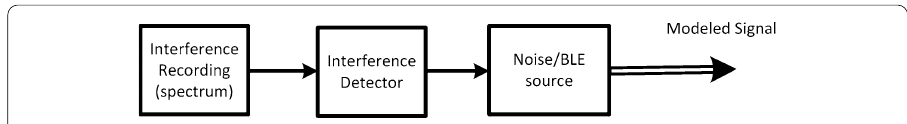
Fig. 16 Process flow graph of spectrum-based interference model